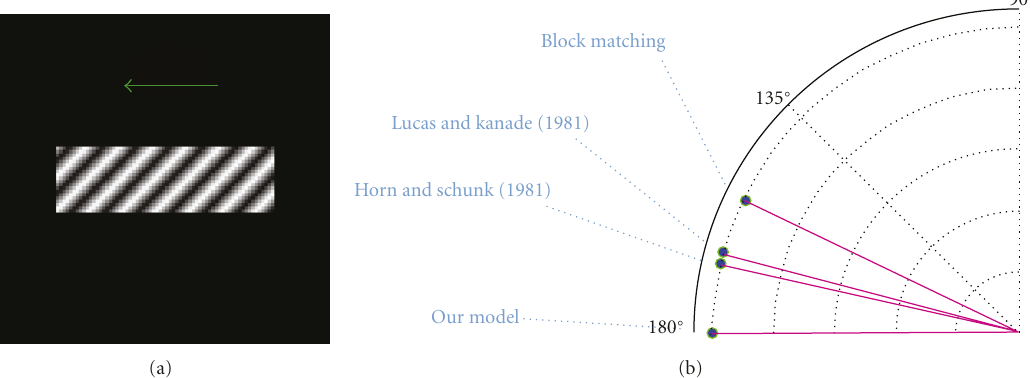
Figure 8: The biologically motivated mechanisms for motion processing demonstrate their capability to process test data used in perceptual experiments. The results were compared against the responses generated by computer vision algorithms that have been tuned to mathematical precision and optimality. We tested a classical block matching scheme often used in simple video encoders as well as more elaborate mechanisms for least-squares optimization of local flow (Lucas and Kanade [44]) and a regularization scheme that imposes a first-order smoothing constraint to minimize the total change in flow field gradient [2]. One example test case is the barberpole illusion (a). Humans perceive a horizontal motion for the stimulus with a moving grating behind a horizontal aperture. Classical computer vision approaches are biased in their global estimation by the normal motion direction for the extended bars. This is indicated by the upward motion at the smaller edges of the aperture which is shown by the mean velocity direction